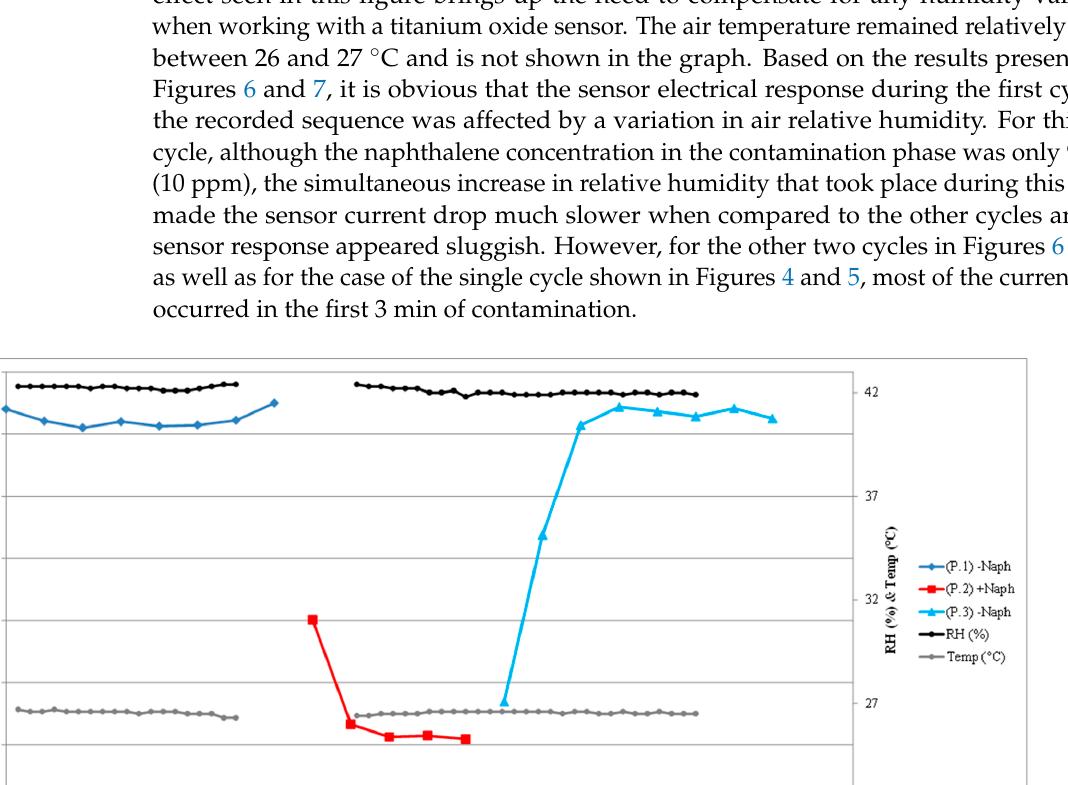
Figure 5. The same cycle of sensor response shown in Figure 4 is presented again here but now correlated in time with measured air relative humidity and temperature. The scale on the right vertical axis now corresponds to either the relative humidity or the temperature in degrees Celsius. in Figure 6. These three cycles were run independently and separately from the run of the